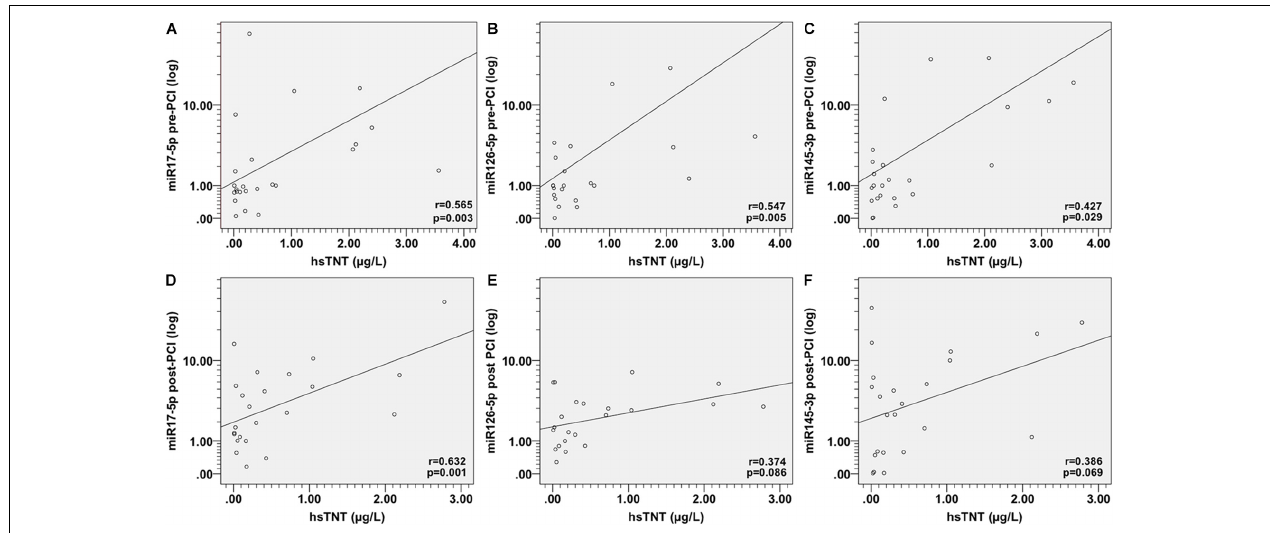
FIGURE 4 | Spearman correlations between circulating miRNAs and HsTNT in AMI patients. The scatter plots show the correlation between HsTNT and (A) miR-17-5p pre-PCI, (B) miR-126-5p pre-PCI, (C) miR-145-3p pre-PCI, (D) miR-17-5p post-PCI, (E) miR-126-5p post-PCI, and (F) miR-145-3p post-PCI, in the population ( n = 29) with